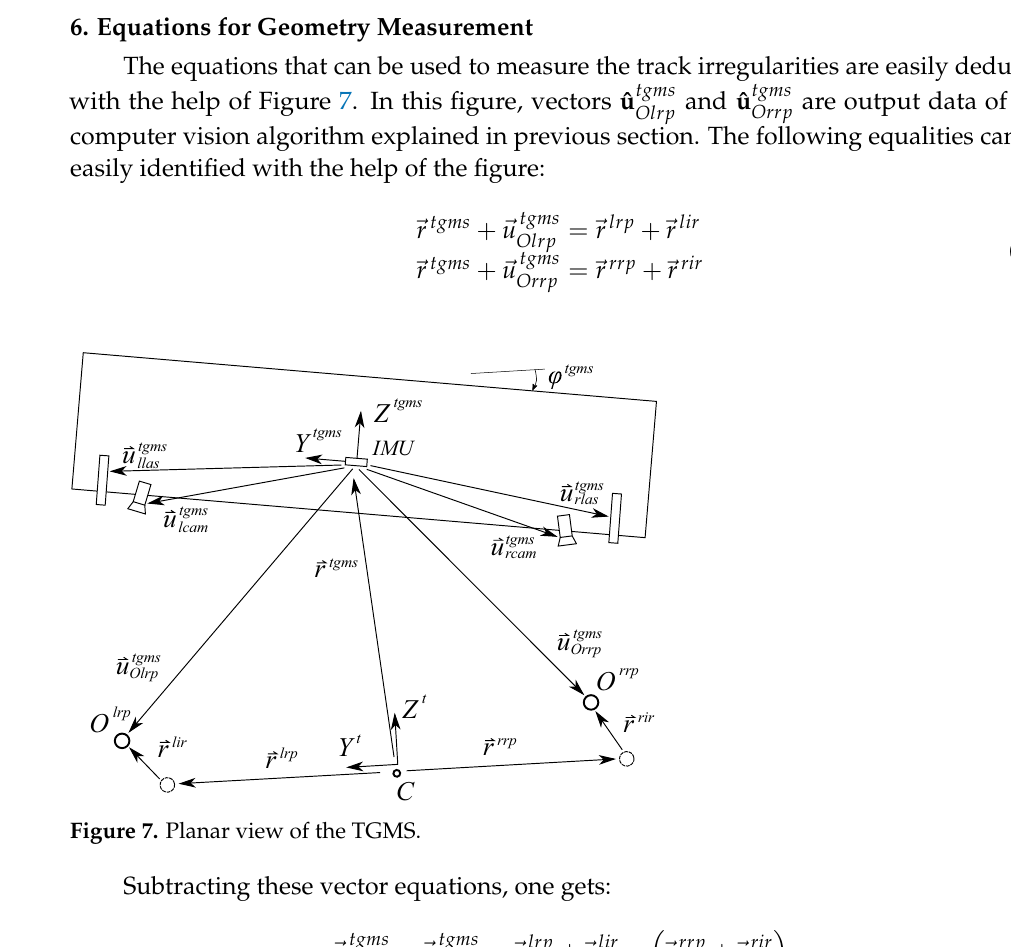
Figure 6. Cloud of points detected with computer vision ( a ). UIC 54 E1 rail-head profile ( b ).